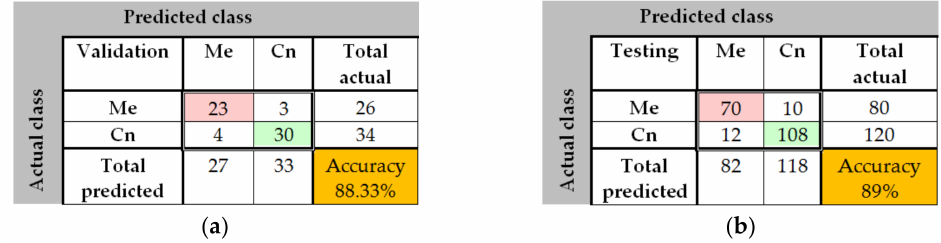
Figure 15. Confusion matrices for ISIC 2019 database (Me—melanoma, Cn—common nevus):